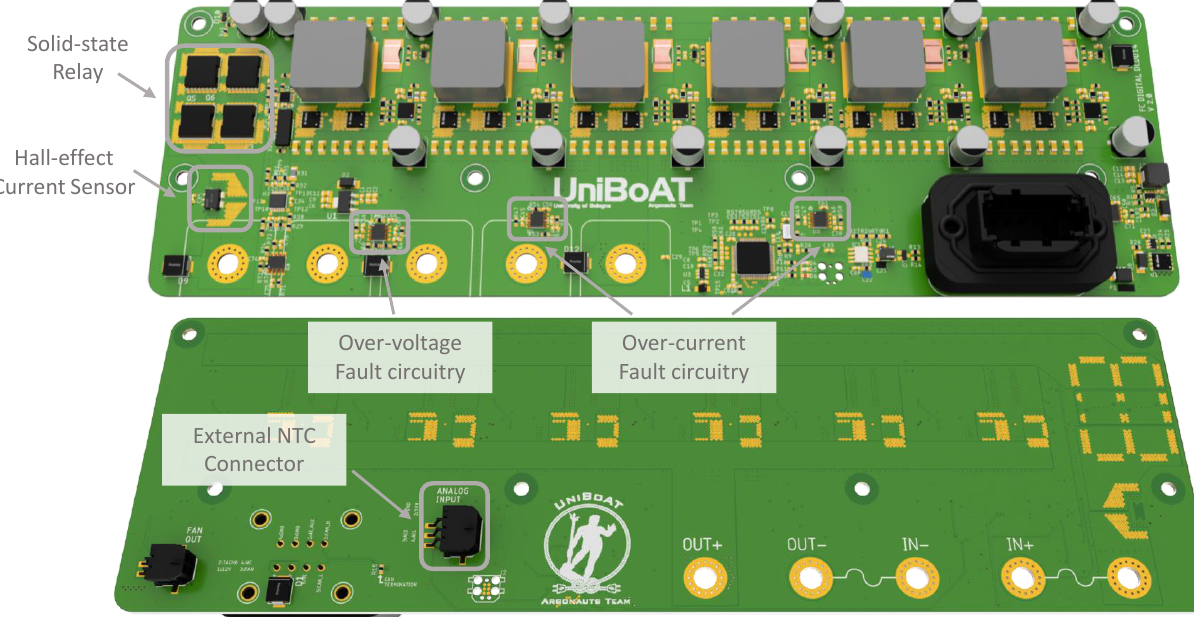
Figure 6. Top and bottom sides of the designed PCB with